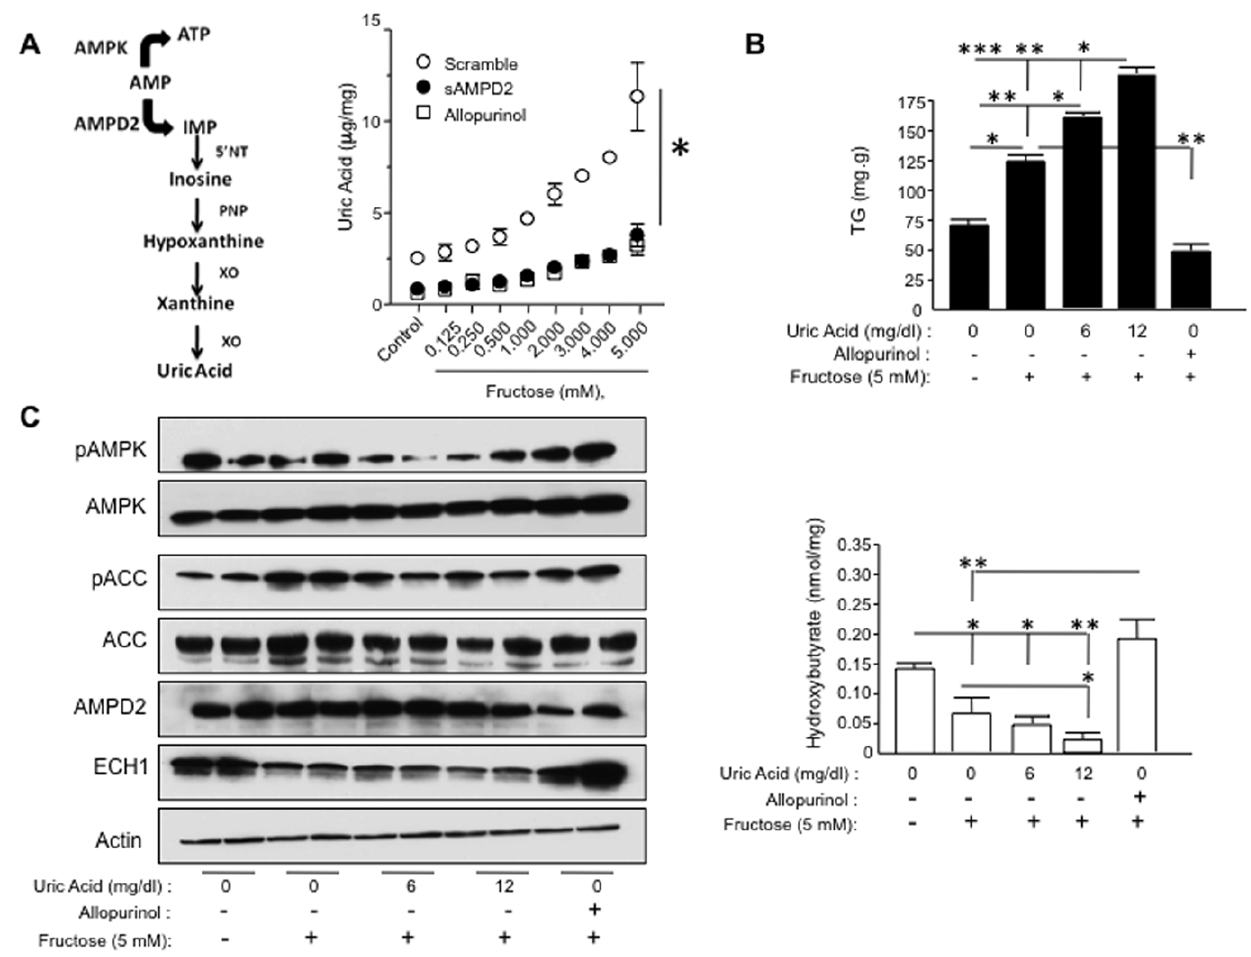
Figure 6. Uric acid negatively regulates AMPK activity. A) Schematic representation of downstream metabolites produced from AMP by AMPD2. Right, uric acid levels –the final product of this route- are increased in HepG2 cells exposed to fructose in a dose-dependent manner. Both inhibiting xanthine oxidase activity with allopurinol or silencing AMPD2 significantly inhibits uric acid generation. *p , 0.05. B) Uric acid further increases fructose-induced triglyceride accumulation (top) and decreases b - hydroxybutyrate levels (bottom) in a dose-dependent manner while allopurinol blocks it. *p , 0.05, **p , 0.01, ***p , 0.001 C) Representative western blot demonstrating that uric acid inhibits fructose-mediated activation of AMPK with significantly lower ACC phosphorylation at ser79 and ECH1 levels in a dose-dependent manner. In contrast, allopurinol (100 m M) further increases the activation of AMPK with significantly higher ACC phosphorylation at ser79 and ECH1 levels.